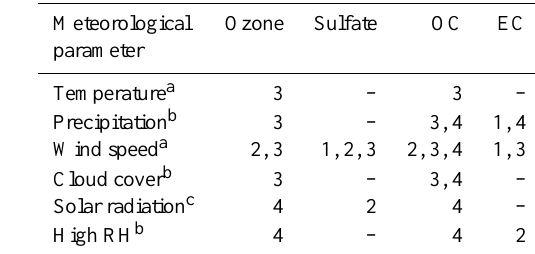
Table 3. Quarters of the year when measured Look Rock air quality was significantly ( p <0.05) associated with observed